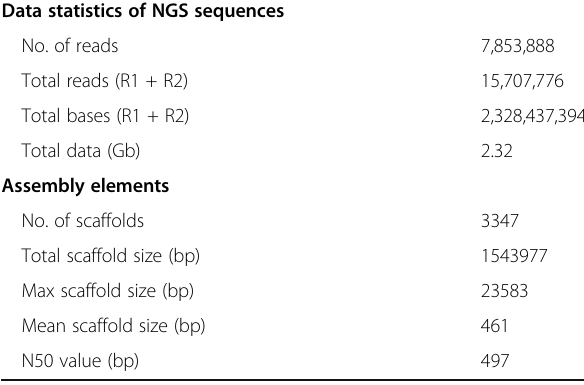
Table 2 Data statistics of NGS of PCR product and de novo assembly Data statistics of NGS